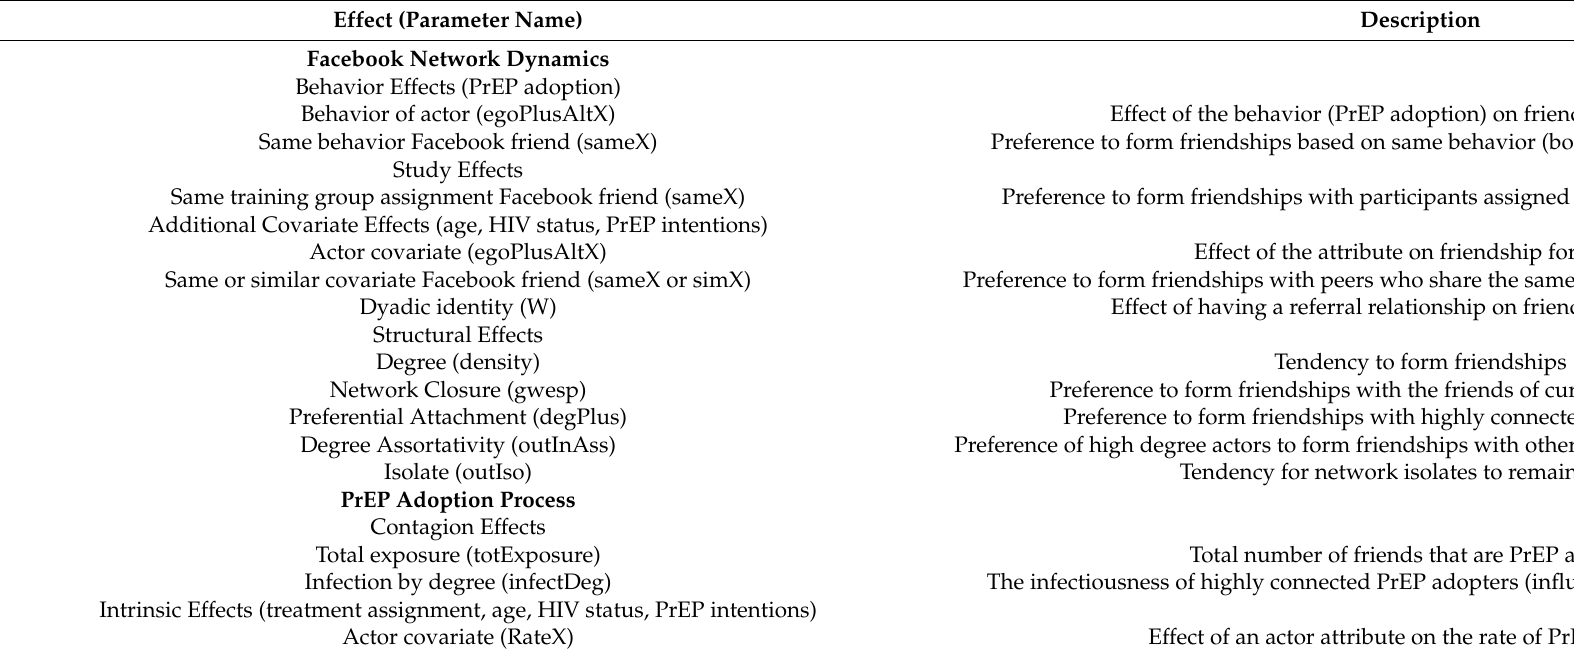
Table 1. Description of the effects included in the network and adoption process